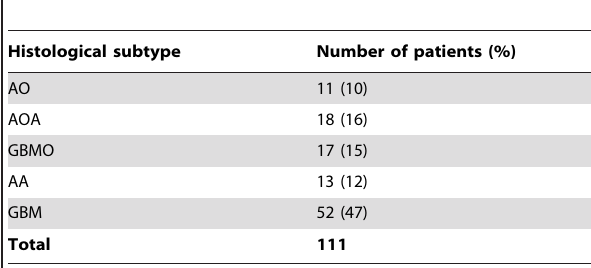
AA: anaplastic astrocytoma, AO: anaplastic oligodendroglioma, AOA: anaplastic oligoastrocytoma, GBM: glioblastoma, GBMO: glioblastoma with oligodendroglioma component.